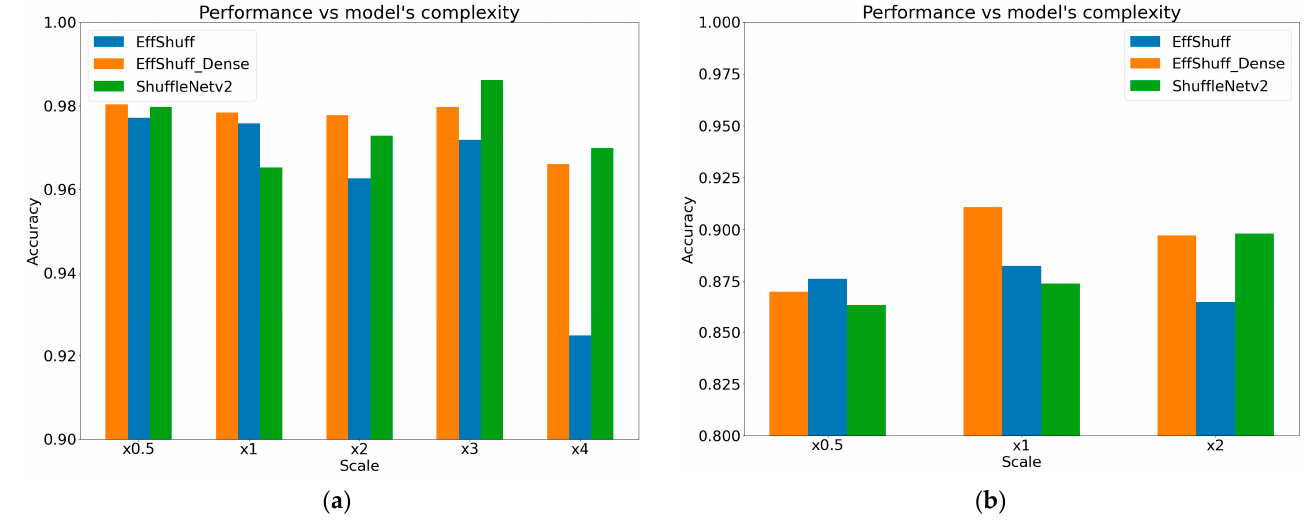
Figure 10. Performance (accuracy) comparison of our proposed EffShuffNet and ShuffleNetv2 with respect to the model’s complexity. ( a ) The Audience dataset: age prediction; ( b ) the NA Birds dataset: class prediction.